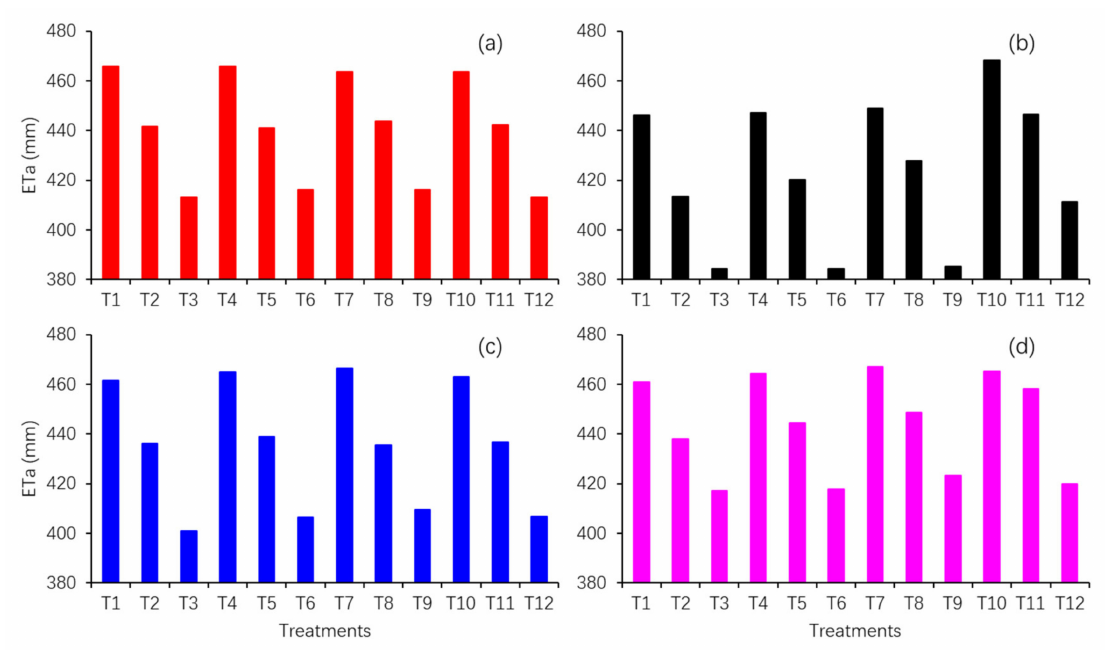
Figure 2. Actual evapotranspiration ( ET a ) of winter wheat in the seasons: ( a ) 2014–2015, ( b ) 2015–2016, ( c ) 2016–2017, and ( d ) 2017–2018. T1, T2, and T3 were I f , I 0.8 f , and I 0.6 f , respectively (N120); T4, T5, and T6 were I f , I 0.8 f , and I 0.6 f , respectively (N160); T7, T8, and T9 were I f , I 0.8 f , and I 0.6 f , respectively (N200); and T10, T11, and T12 were I f , I 0.8 f , and I 0.6 f , respectively